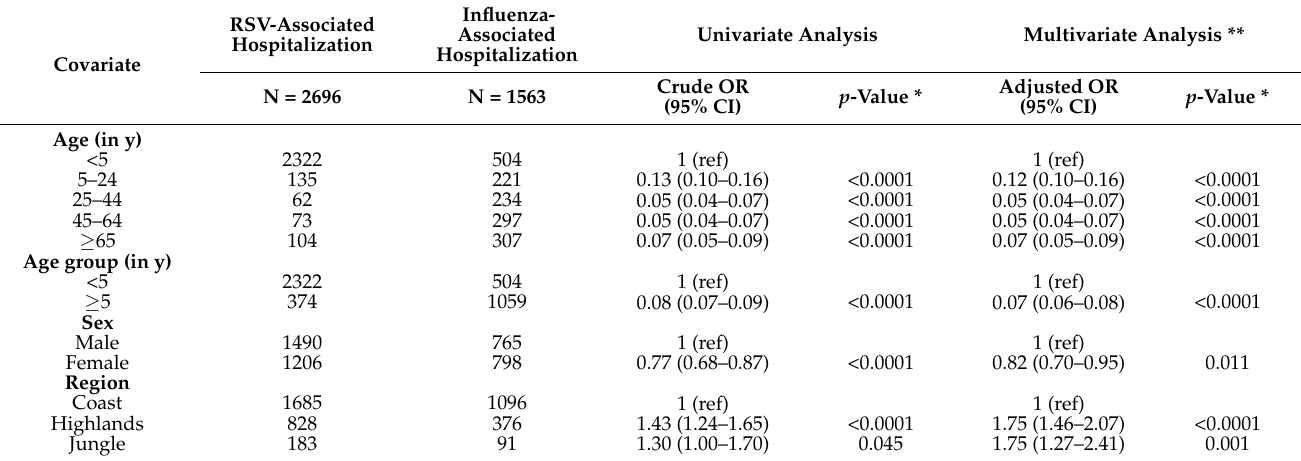
Table 3. Factors associated with the respiratory syncytial virus compared to the influenza virus among patients hospitalized in Peru,